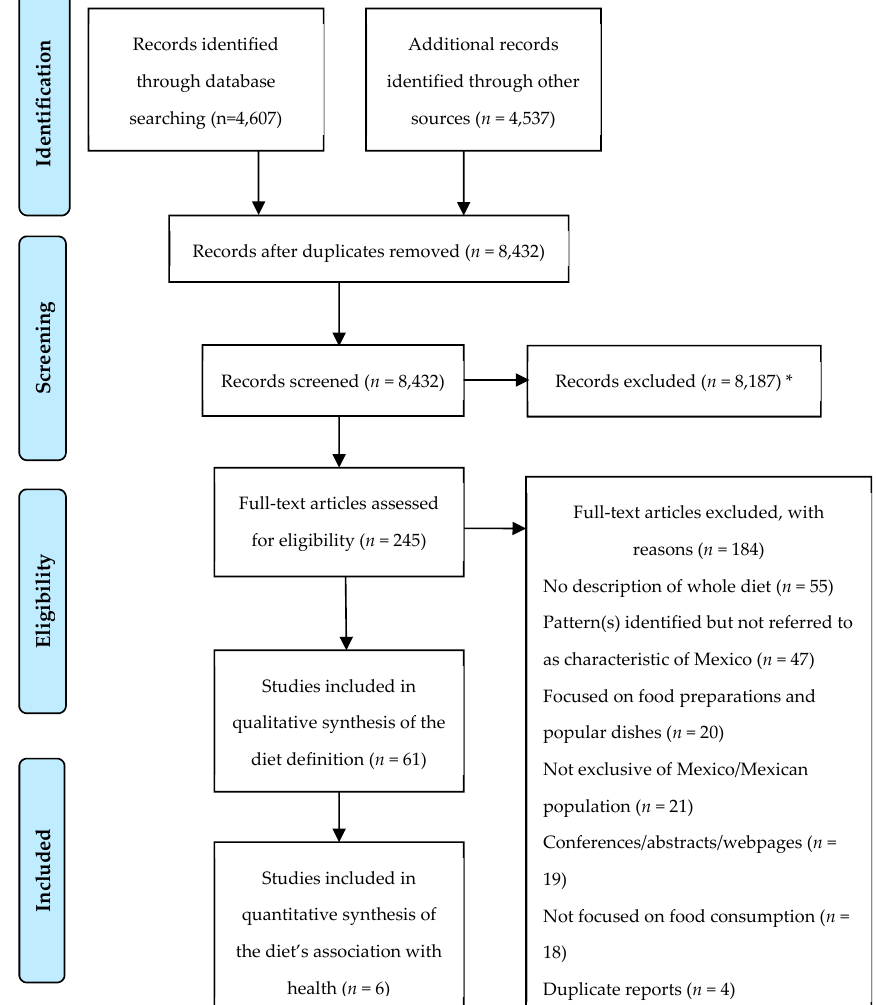
Figure 1. Preferred Reporting Items for Systematic reviews and Meta-Analyses (PRISMA) flow diagram of literature search and study selection. * Seven of these records could not be retrieved despite several attempts to contact the corresponding